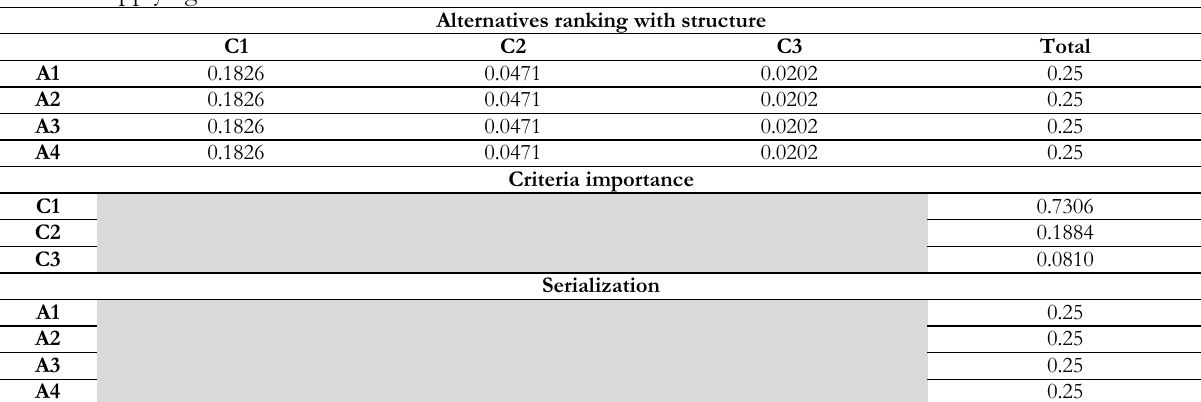
Table 2. Applying AHP method to scenario II